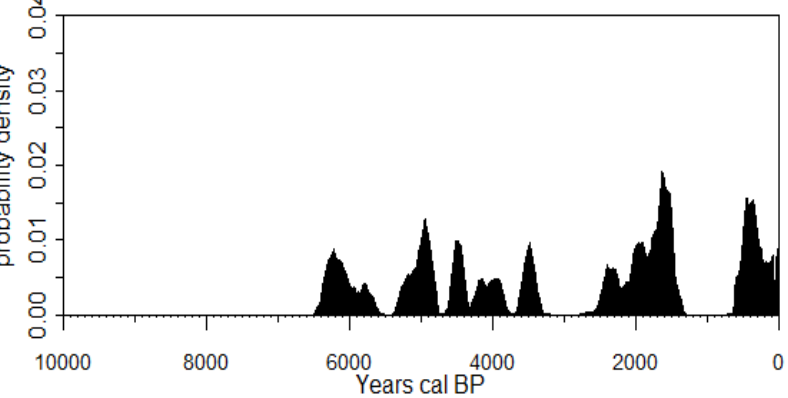
Figure 18. Radiocarbon dates from the Boreda Gamo Cave archeological sites (approximately 13 km distant from the Chencha study site at an elevation above 2500 m) based on artefact materials ([23])